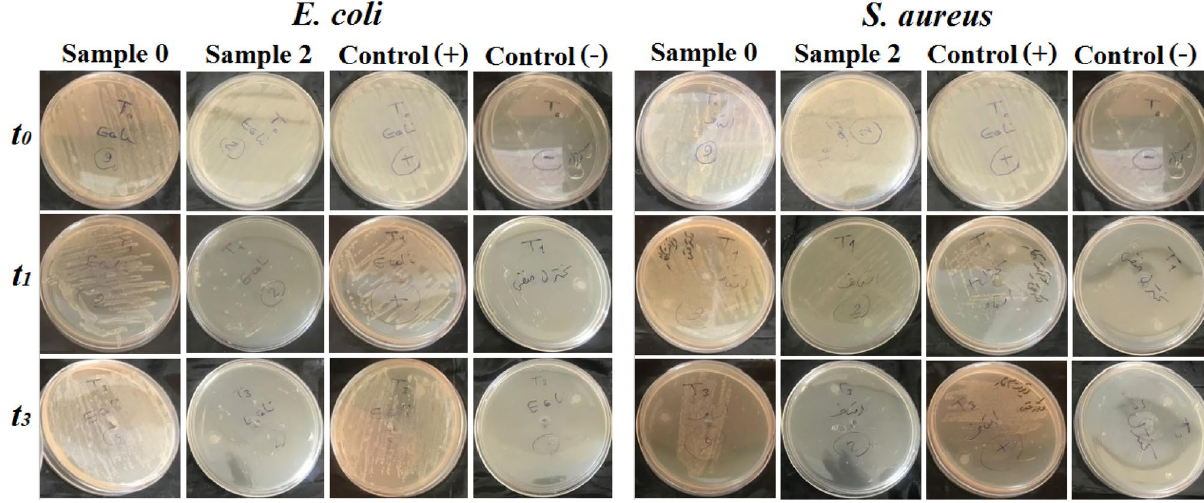
Figure 9. Antibacterial activity of coated fabric (Sample 2, NS-coated fabrics at 2, 10, 20, and 50 mM silver nitrate concentrations, and 25 min sonication time) in comparison with uncoated fabric (Sample 0, uncoated fabric) at different experiment time. Control ( +): saline without sample, Control (−): saline with uncoated sample and without